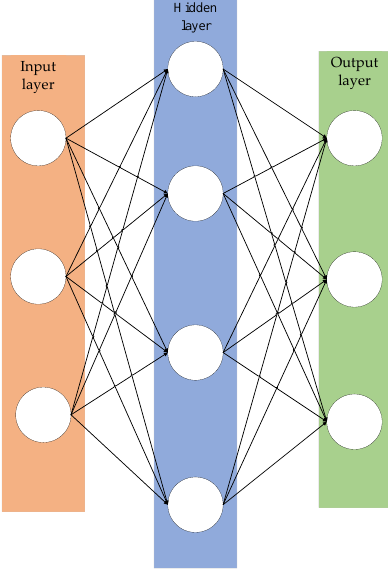
Figure 2. CNN schematic.